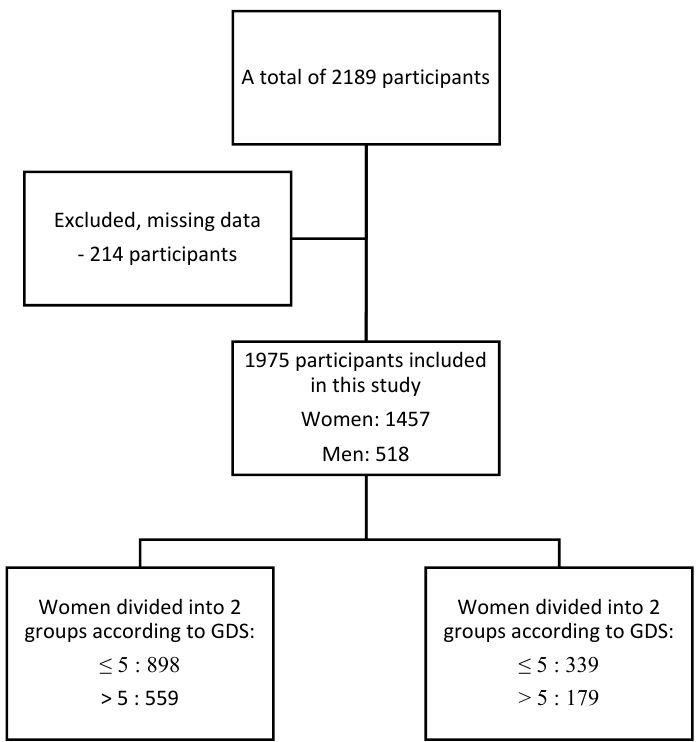
Figure 1. Flowchart of the study.